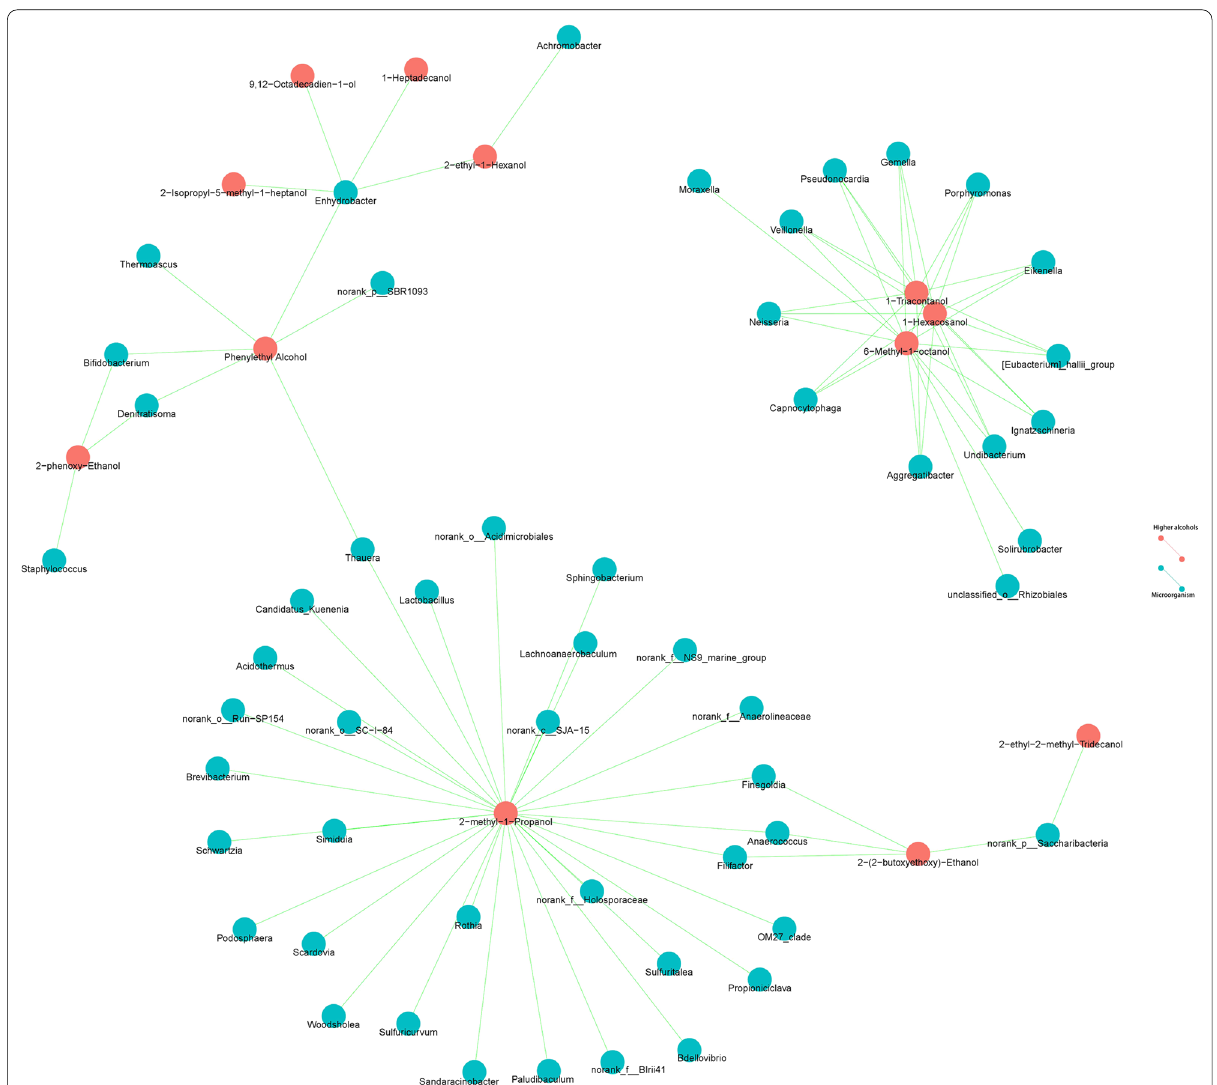
Fig. 5 Correlation between HA-producing core bacteria and higher alcohols. The green line indicates correlation was built between HAs and microorganisms; the blue pie indicates micro-biota composition; the red pie indicates HA